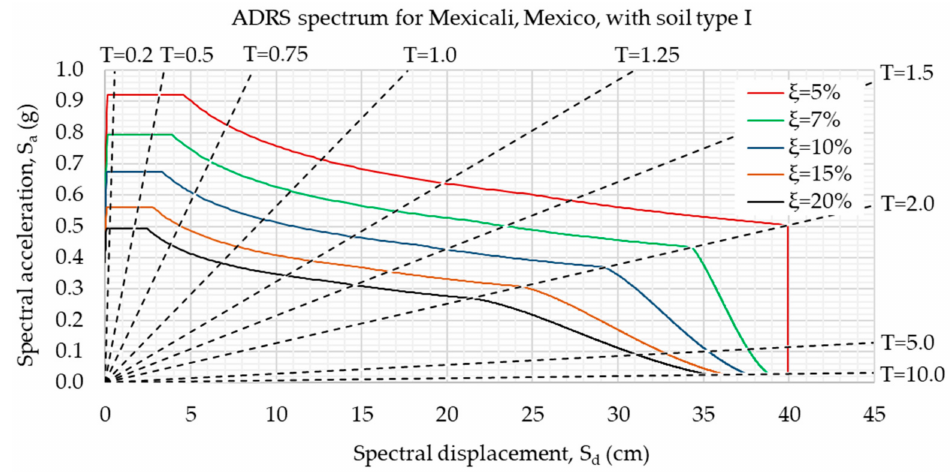
Figure 19. Example of ADRS response spectra used on several